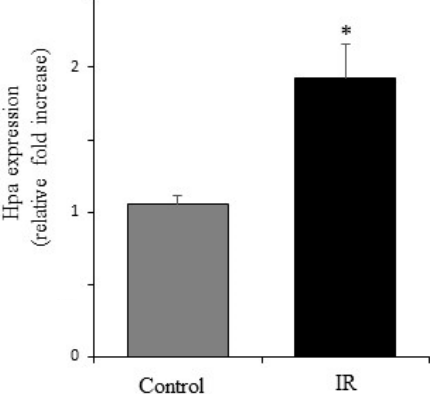
Figure 2. IR induces heparanase expression in the kidneys of irradiated mice. C3H/HeNHsd mice remained untreated (grey bar) or were treated with conformal bilateral kidney irradiation as described in Methods (black bar). Mice were sacrificed and the renal cortex from each kidney was extracted and stored at − 80 ◦ C. Heparanase expression was assessed by qRT-PCR. Error bars represent ± SE; n = 3 mice per group; * p < 0.008.